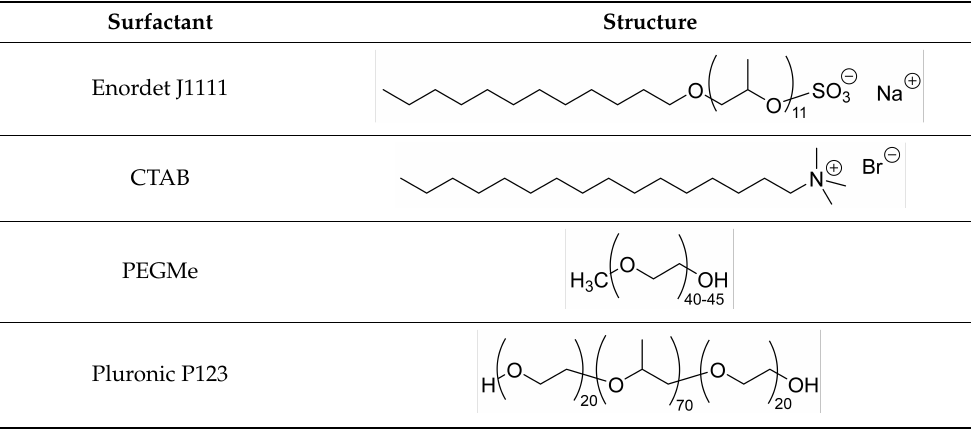
Table 1. Structure of the surfactants employed in this